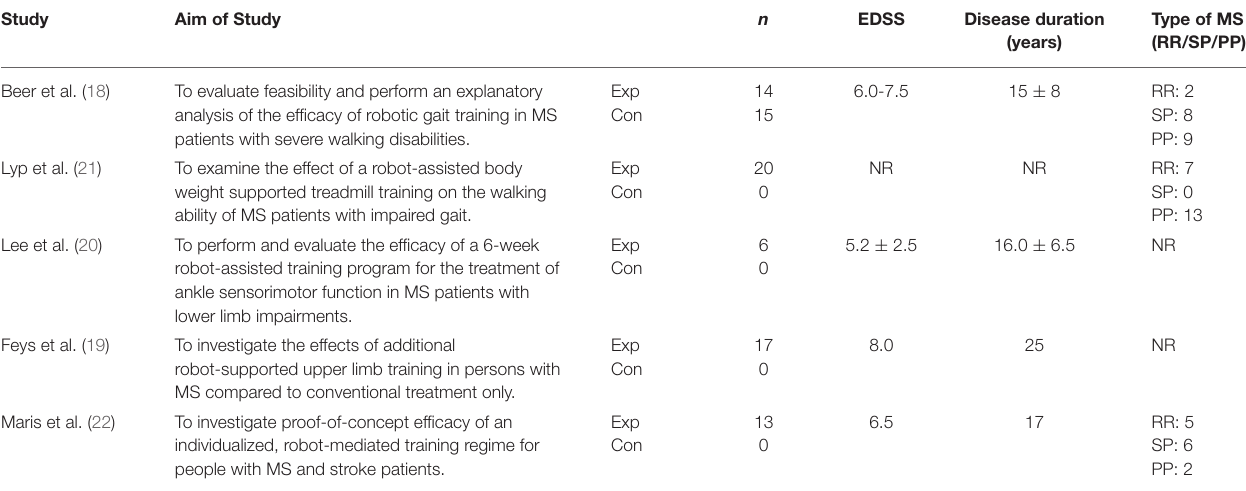
TABLE 3 | Summary of extracted articles included in this re. Study